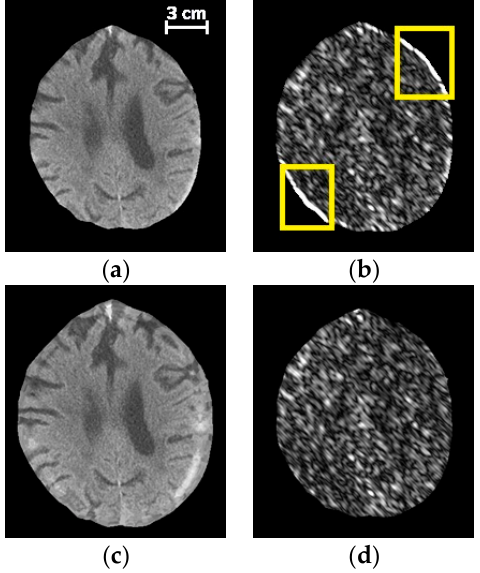
Figure 3. The effect of padding on a Gabor descriptor. ( a ) The original image before padding, ( b ) the magnitude response for a Gabor filter at 3 method, ( d ) the magnitude response for the Gabor filter at